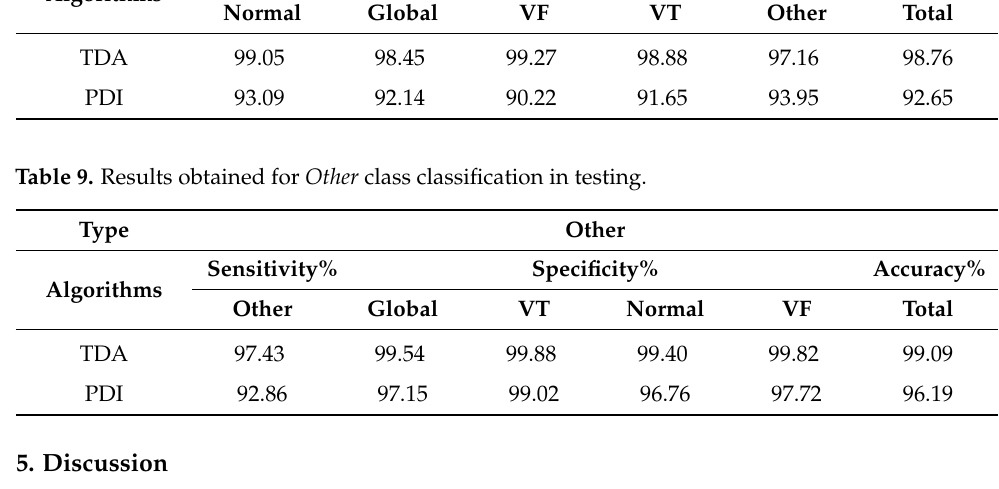
Table 8. Results obtained for Normal class classification in testing. Type